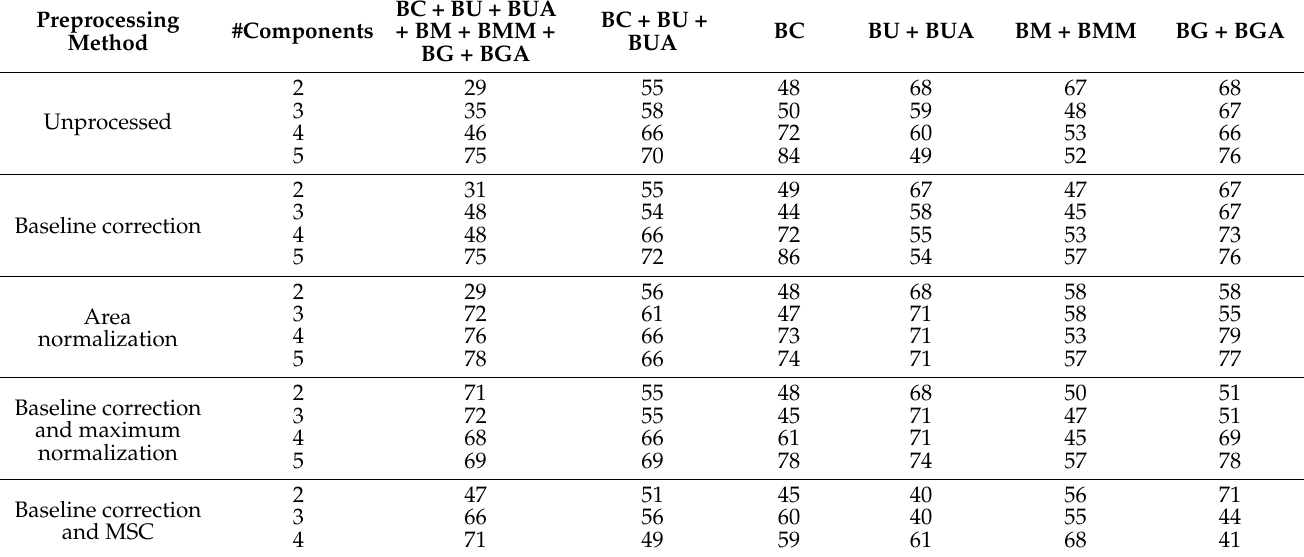
to predict if biodiesel is contaminated, if is contaminated with vegetable oils (BC + BU +